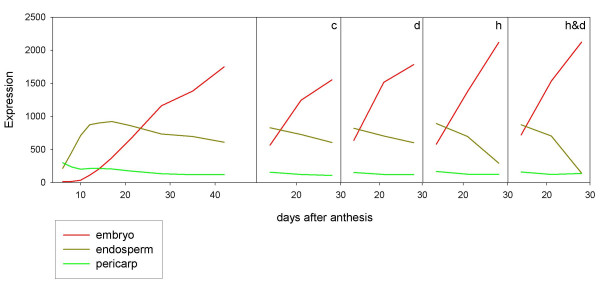
Geometric average of expression for all probesets likely to be predominantly expressed in embryo, endosperm or pericarp tissues for both developmental series (left panel) and controlled environment experiment with control (c), drought (d), heat (h) and heat & drought (h&d) treatments (right panels). Embryo, endosperm and pericarp sets contain 104, 496 and 296 probesets, respectively.